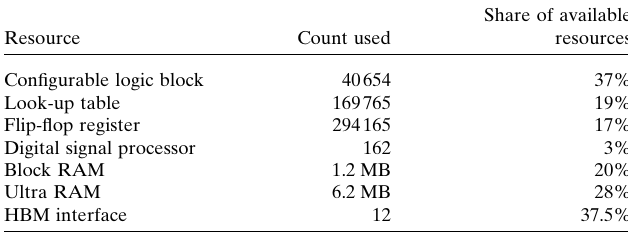
Table 2 FPGA resource utilization is relatively low for the XCVU35P chip, allowing for more functionality to be implemented in the future. Data from the Xilinx Vivado 2022.1 tool, after synthesis and implementation. Resource